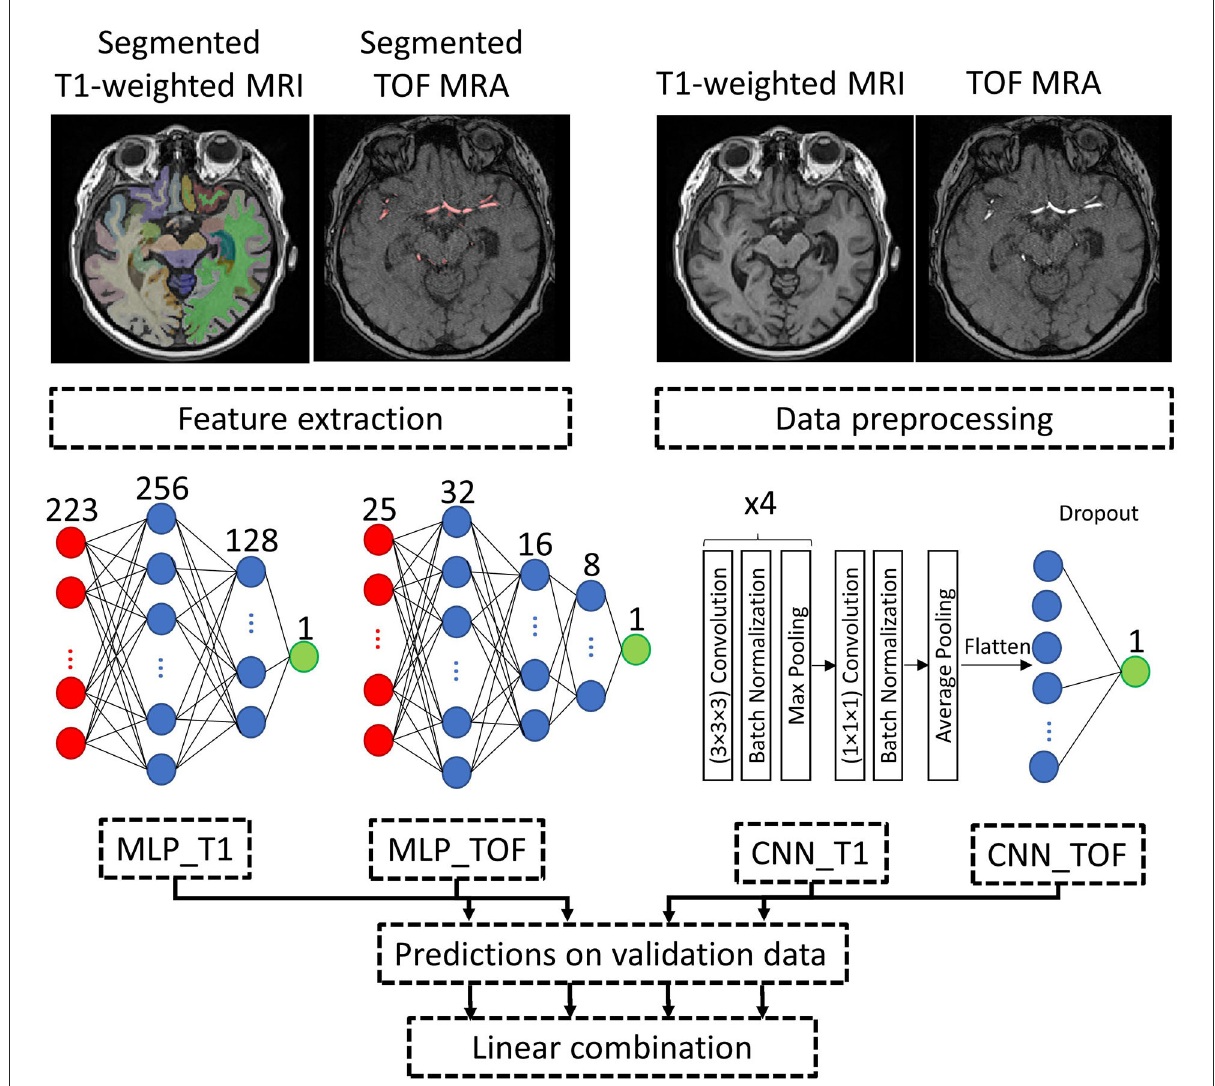
FIGURE2 Processing pipeline. Example input data and approach to combine the brain age prediction models using different input types. MLP and CNN model architectures are detailed, with both CNNs (CNN_T1 and CNN_TOF) having the same model architecture. Red: input layer, Blue: